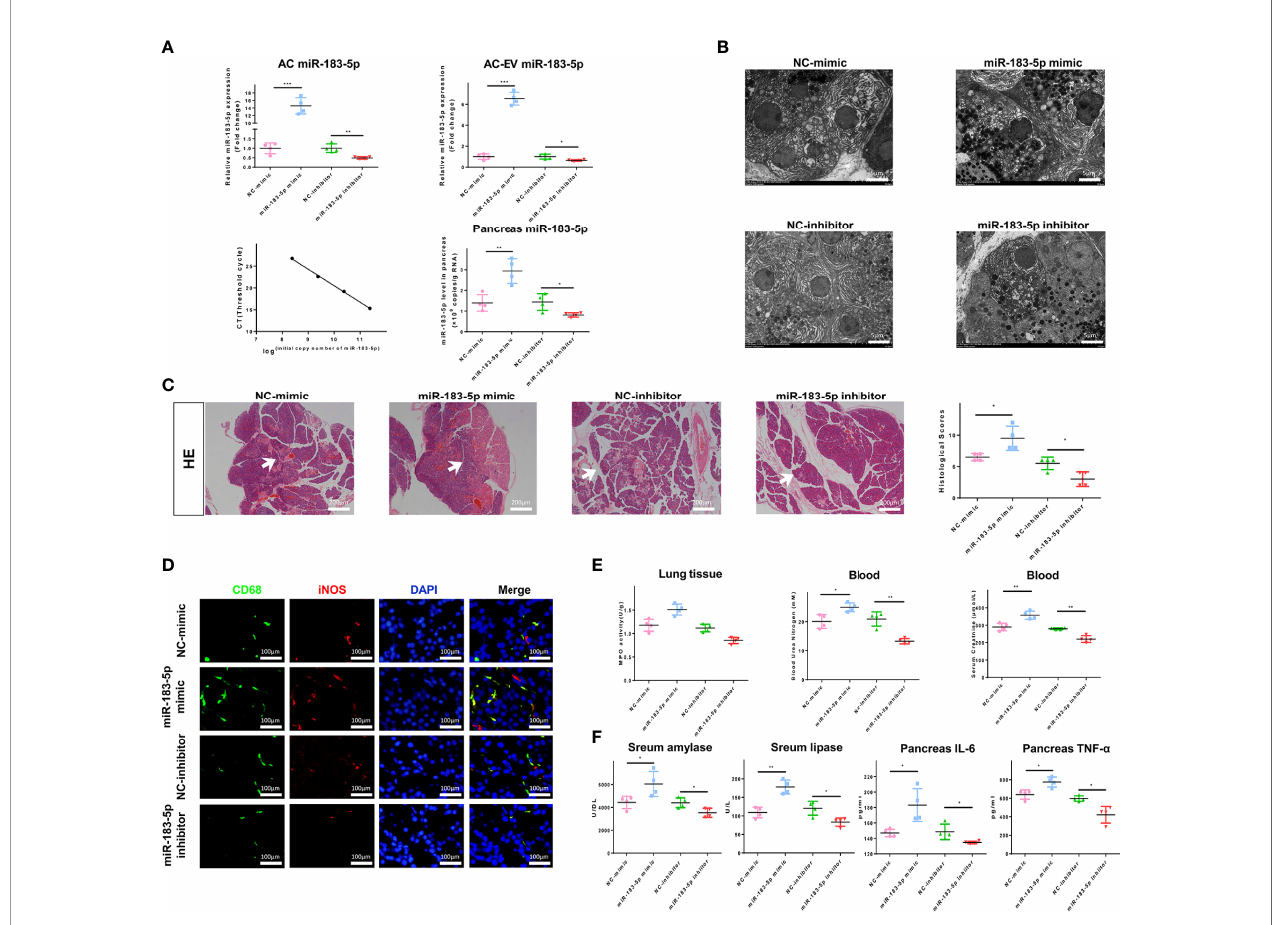
FIGURE 6 | AC-derived EV miR-183-5p aggravates pancreatitis in AP rats in vivo . (A) Overexpression and inhibition of miR-183-5p expression in ACs and EVs were detected using qRT-PCR. The absolute expression of miR-183-5p in pancreatic tissue was calculated from a standard curve of logarithmic values of miR-183-5p concentrations and the CT value. (B) Electron microscopy photographs of pancreatic sections obtained from the above groups of AP rats. Scale bar, 10 m m. (C) Representative photographs and histological scores of HE-stained pancreatic sections obtained from AP rats in the following groups at 6 h after the EV injection s: NC-mimic, NC-inhibitor, miR-183-5p mimic and miR-183-5p inhibitor. Pancreatic injury is indicated by the white arrows. Scale bar, 200 m m. (D) Microscopy images of the distribution of CD68 and iNOS immunostaining in the indicated colors in pancreatic sections from the aforementioned groups of AP rats. Scale bars, 100 m m. The fold change in the number of macrophages co-expressing CD68 and iNOS in the four groups was determined. Scale bar, 400 m m. (E) Creatinine and urea nitrogen levels in the blood and MPO levels in the pancreas were determined. (F) Levels of amylase and lipase in the blood and in fl ammatory cytokines in the pancreas from the aforementioned groups of AP rats were determined by ELISA. All experiments were repeated three times. * p <0.05, ** p <0.01, *** p <0.001. NC- mimic: AP rats treated with EVs from acinar cells transfected with the NC-mimic, miR-183-5p mimic: AP rats treated with EVs from acinar cells transfected with the miR-183-5p mimic, NC-inhibitor: AP rats treated with EVs from acinar cells transfected with the NC-inhibitor, miR-183-5p inhibitor: AP rats treated with EVs from acinar cells transfected with the miR-183-5p